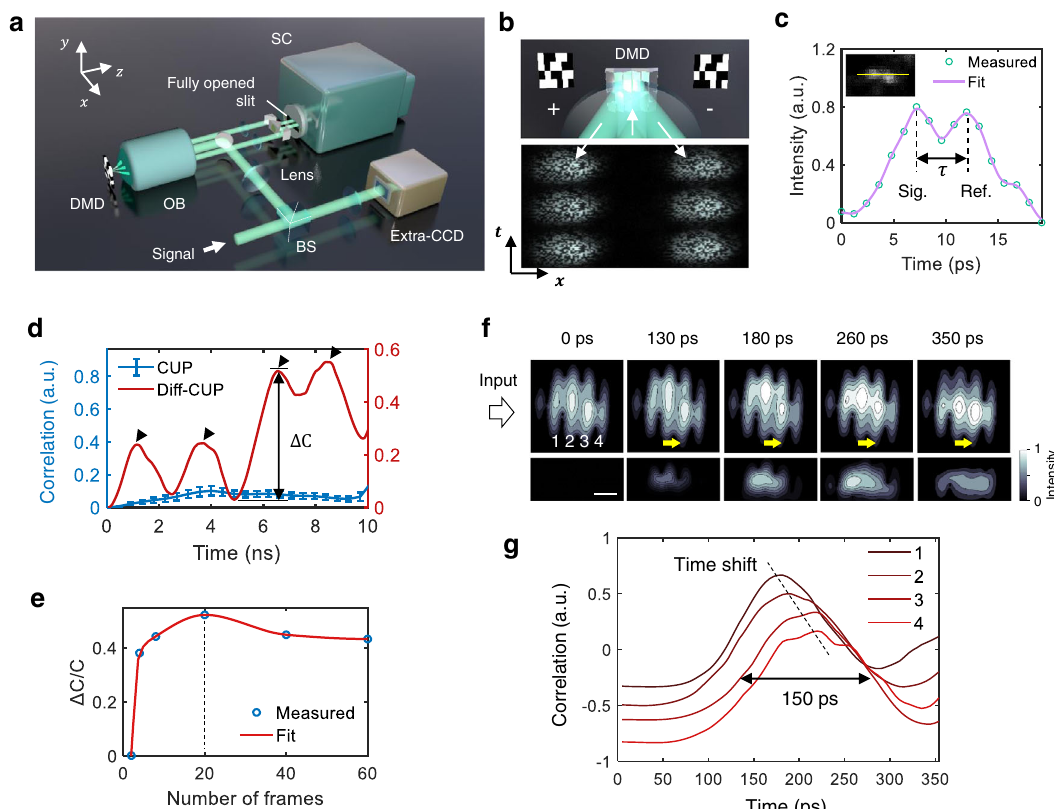
Fig.4|CodedDiff-CUPimagingofpropagatingEMPsinanLNcrystal.a Lossless- encoding CUP setup in the Diff-CUP system. DMD, digital micromirror device; OB, reconstructed movies of EMPs propagating in the LN crystal acquired by conven- tional CUP and coded Diff-CUP. The correlation curves indicate the phase change